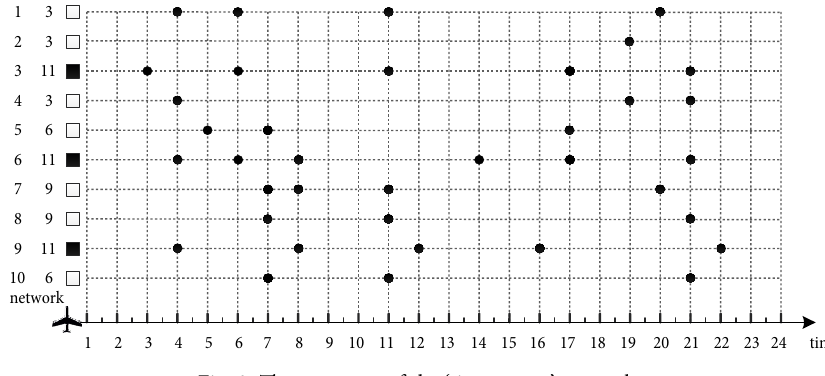
Fig. 2. The structure of the ‘time–space’ network